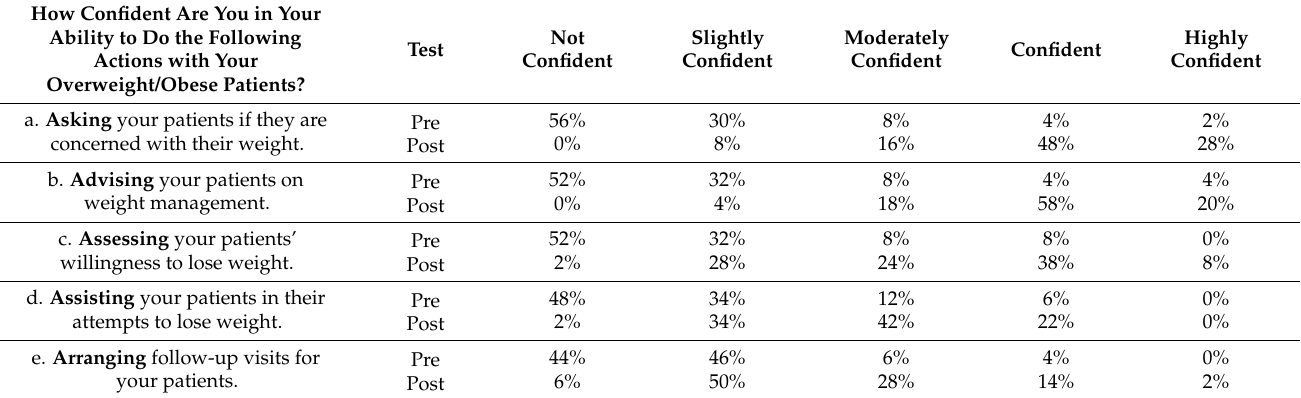
Table 3. Questionnaire Item 12 Response Frequency *.